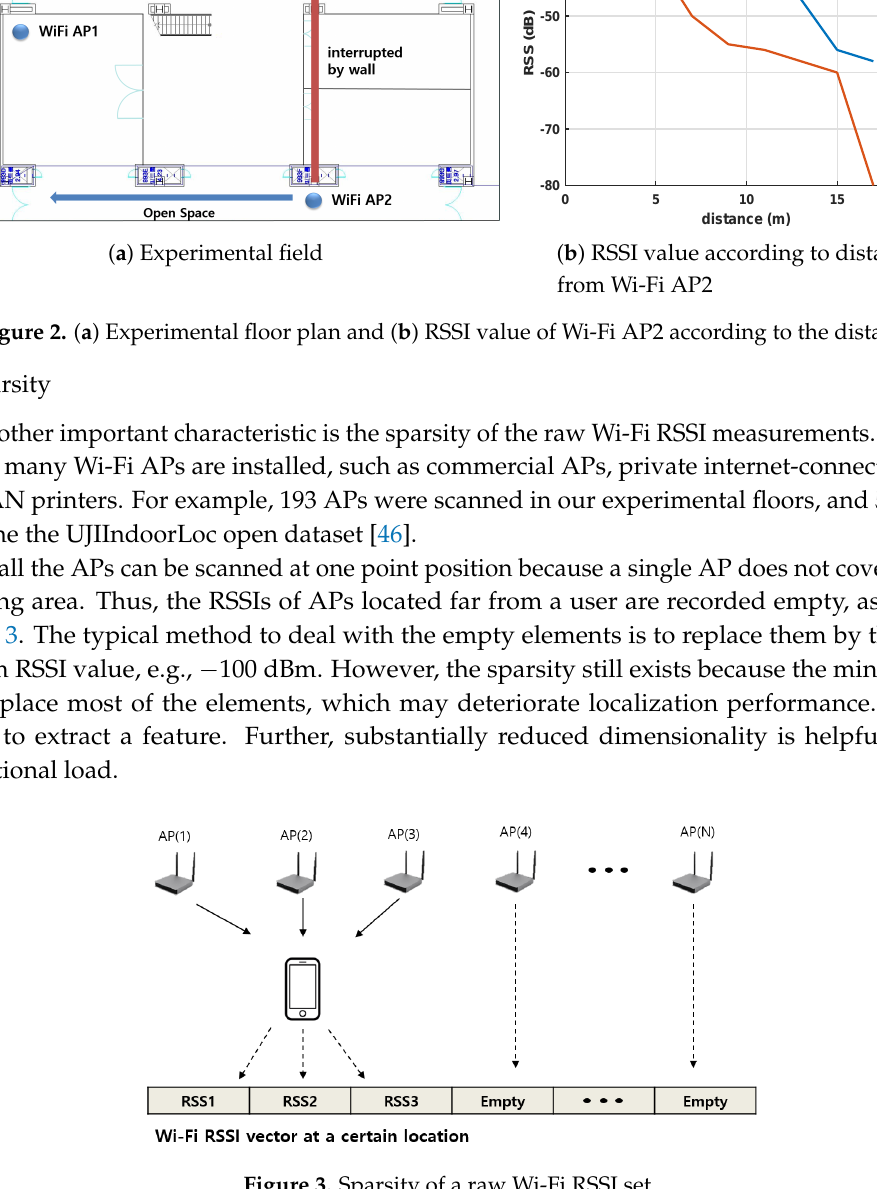
Figure 3. Sparsity of a raw Wi-Fi RSSI